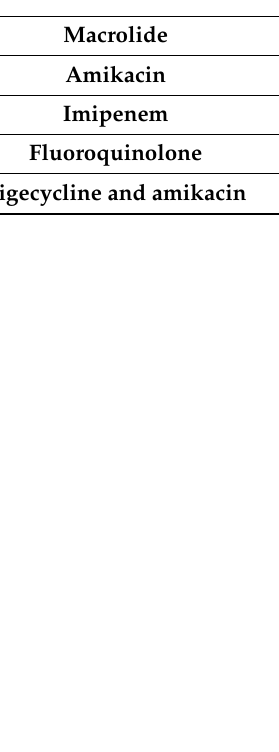
Table 4. Multivariable analysis for treatment outcomes according to Individual Antibiotics.